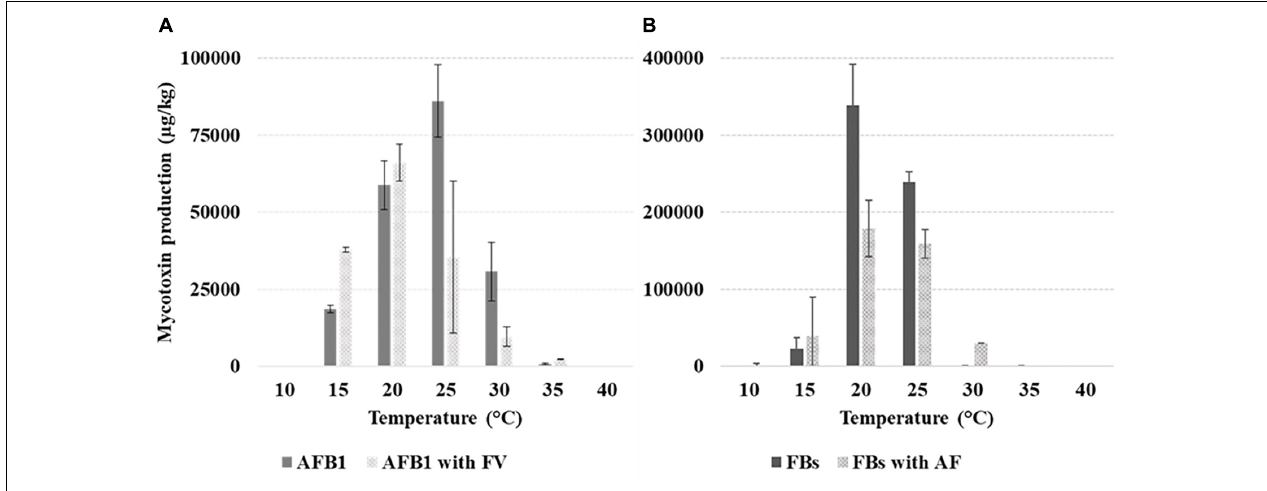
FIGURE 3 | Production ( µ g/kg) of aflatoxin B 1 (AFB 1 ) (A) and fumonisins [FB 1 + FB 2 (FBs)] (B) by Aspergillus flavus ( Af ) and Fusarium verticillioides ( Fv ) grown alone or together, at different T of incubation (10–40 ◦ C, 5 ◦ C step). The bars indicate the mean standard error. All experiments were conducted using three replicates and were performed